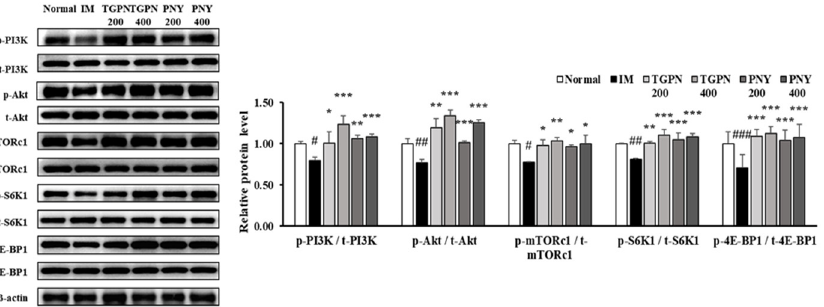
Figure 6. Effect of TGPN and PNY on muscle protein synthesis mechanism in gastrocnemius muscle. Mice were subjected to hindlimb immobilization for one week, except for the normal group, and then administered with TGPN 200, 400mg/kg, or PNY 200, 400 mg/kg for two weeks with continuous immobilization. Relative phosphorylation of PI3K, Akt, mTORc1, S6K1, and 4E-BP1. The protein expression levels were normalized to the β -actin level. The data are expressed as mean ± SD. # p < 0.05, ## p < 0.01, ### p < 0.001 versus normal, * p < 0.05, ** p < 0.01, *** p < 0.001 versus IM.